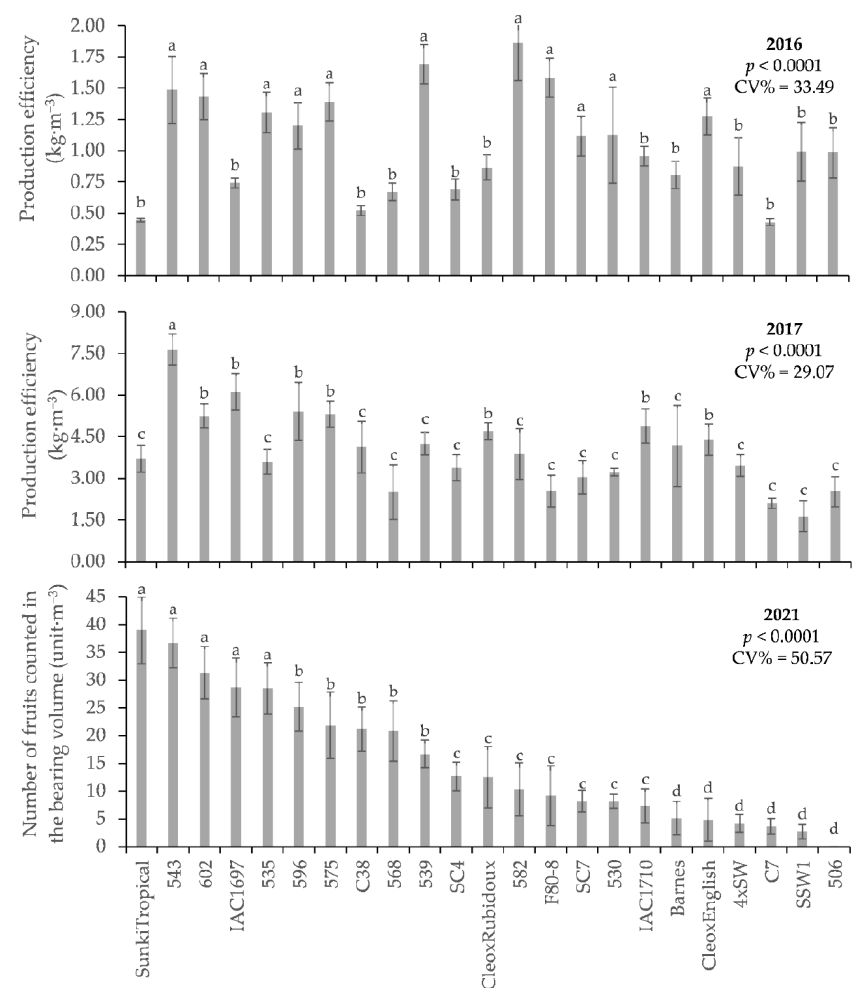
Figure 2. Production efficiency ( PE ) in 2016 and 2017, and mean number of fruits ( NF ) counted per cubic meter of bearing volume in 2021, ten years after the planting of Valencia sweet orange [( Citrus × sinensis (L.) Osbeck] grafted onto 23 rootstocks and cultivated without irrigation in Northwestern São Paulo State, Brazil. Means followed by the same letters belong to the same group by the Scott-Knott test ( p ≤ 0.05). Rootstock acronyms according to Table 1. Sunki Tropical is the control treat- ment.